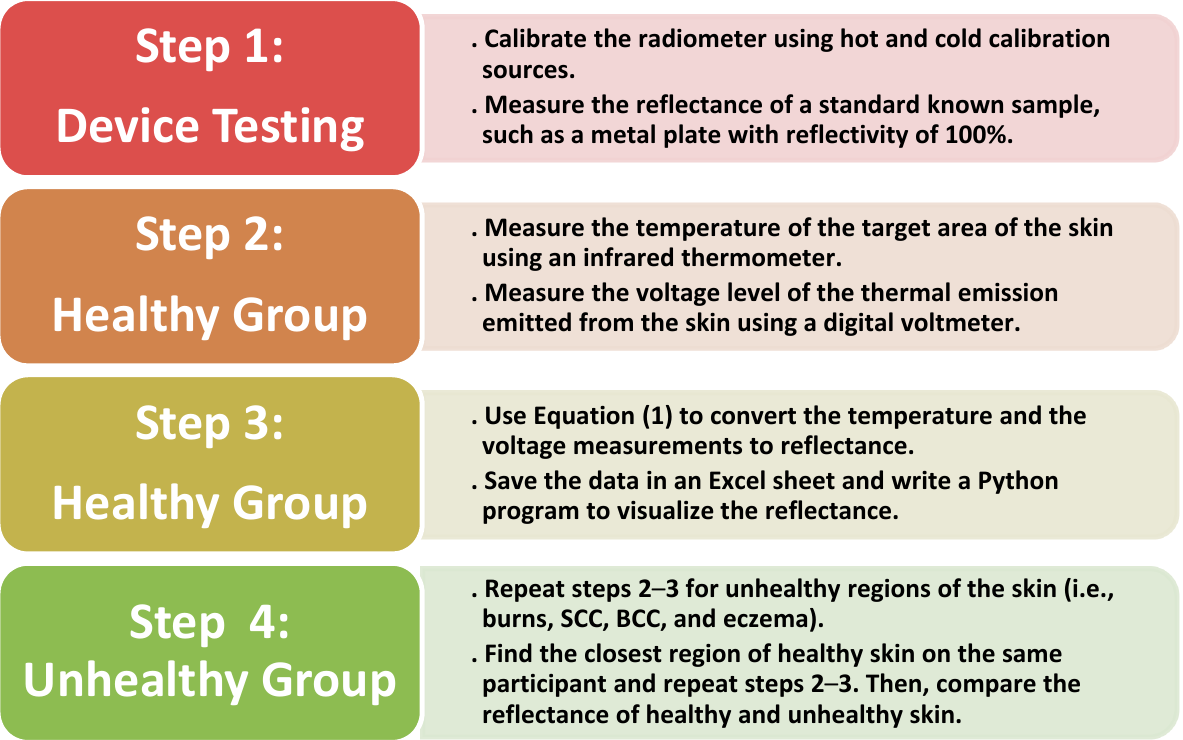
Figure 3. Methodology of collecting and processing the reflectance data for healthy and unhealthy regions of the skin.